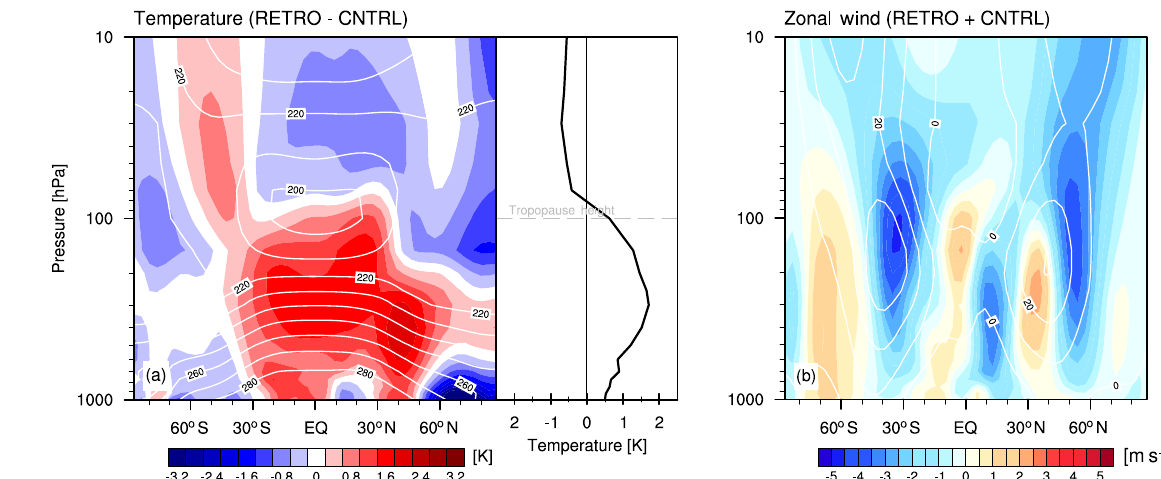
Figure 8. (a) Annually and zonally averaged temperature difference between RETRO and CNTRL (left) and its tropical (20 ◦ S to 20 ◦ N) average (right). The tropopause level indicated in the right panel refers to the cold-point tropopause of the control case. (b) Annually and zonally averaged zonal wind sum of RETRO and CNTRL. White contour lines show the isotherms and isotachs of the control simulation with a contour interval of (a) 10K and (b) 10ms − 1 .